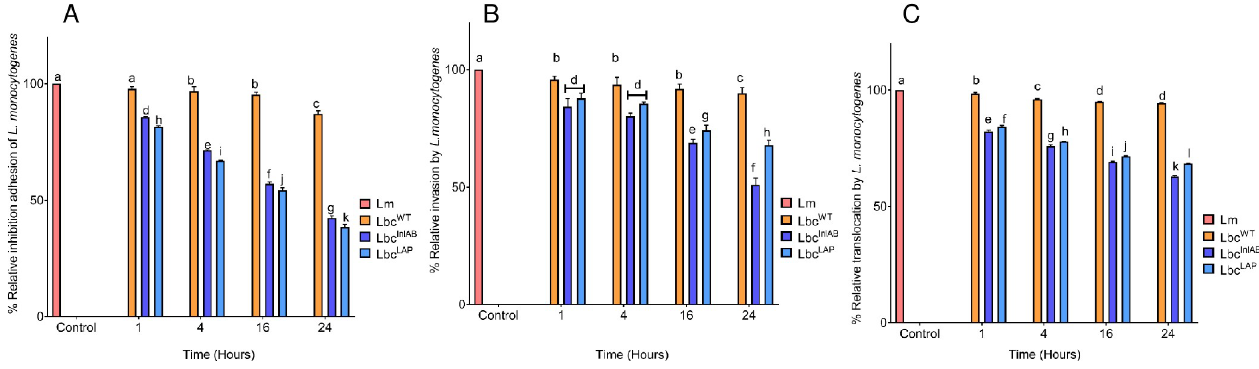
Fig 3. Inhibition of Listeria monocytogenes (Lm) adhesion (A), invasion (B) and translocation (C) by L . casei strains (Lbc WT , Lbc InlAB and Lbc LAP ) over time. Caco-2 cells were pre-exposed to the L . casei strains for 1, 4, 16 and 24 h before infection with Lm for 1 h for adhesion and invasion and 2 h for translocation. Data are averages of three experiments run in duplicates. Error bars are standard deviations of averages of the three independent experiments. For each time point bars marked with different letters (a, b, c, d, e, f, g, h, I, j, k, l) indicate significant difference at p < 0.05.